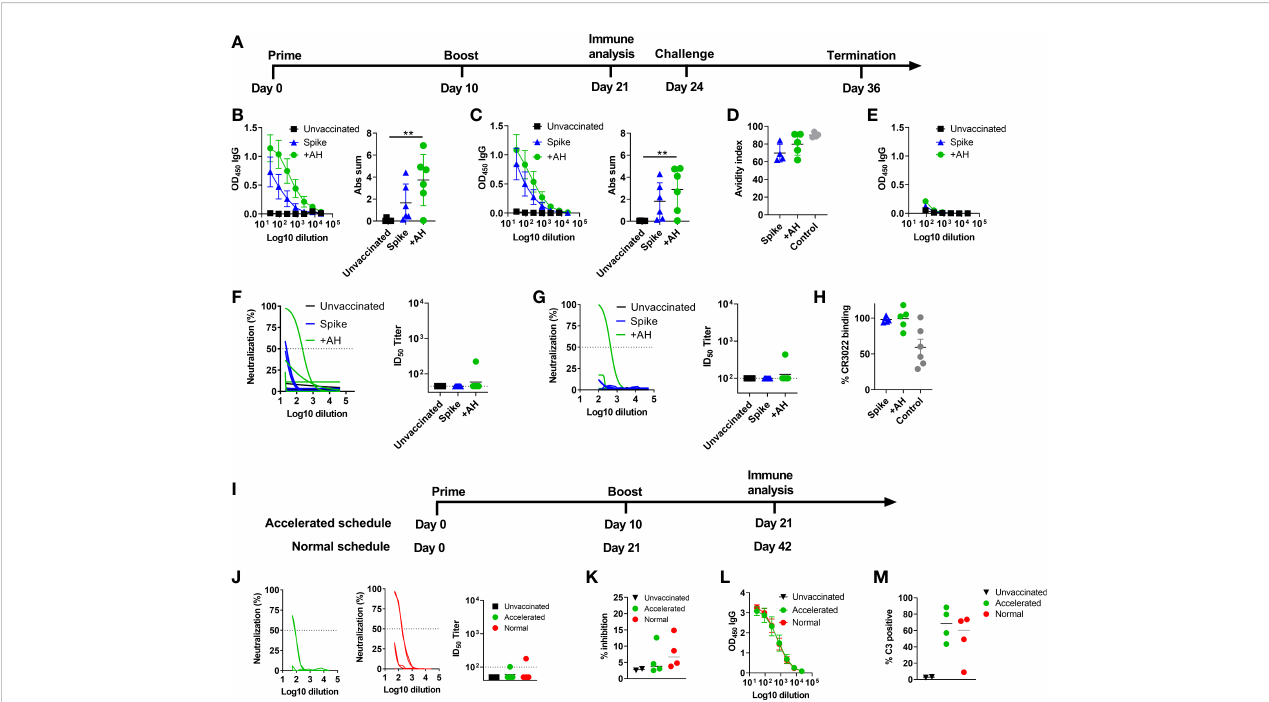
FIGURE 1 Aluminium hydroxide adjuvanted SARS-CoV-2 HexaPro spike protein elicits antibody responses with low neutralizing activity. Syrian Hamsters were immunized with two doses of spike trimer protein alone or formulated in aluminium hydroxide (AH). Serum was sampled at 11 days after the 2 nd immunization. (A) Timeline of the challenge experiment. Six hamsters were included in each group. (B) IgG antibody responses against spike protein from the homologous Wuhan-Hu-1 strain. (C) IgG antibody responses against the receptor binding domain (RBD) from the homologous Wuhan-Hu-1 strain. Mean ± SEM is displayed. Abs sum = sum of absorbances. (D) Antibody avidity against RBD. As a control, convalescent serum (day 14) from hamsters challenged with 1.8x10 5 TCID 50 of SARS-CoV-2 was included. (E) IgG antibody responses cross-reactive towards spike protein from the omicron (B.1.1.529) strain. (F) Neutralization of SARS-CoV-2 (Wuhan-Hu-1) by a pseudovirus neutralization assay and (G) a homotypic culture derived SARS-CoV-2 virus assay. (H) Serum s peci fi city against the CR3022 epitope were tested in a competition ELISA. Data are displayed as reduction in CR3022 binding by serum from vaccinated groups compared to naïve serum. A positive control (mouse anti-spike serum) was included, which gives a 50% reduction in CR3022 binding. (I) Timeline of the experiment comparing accelerated and normal vaccine schedules. Syrian golden hamsters